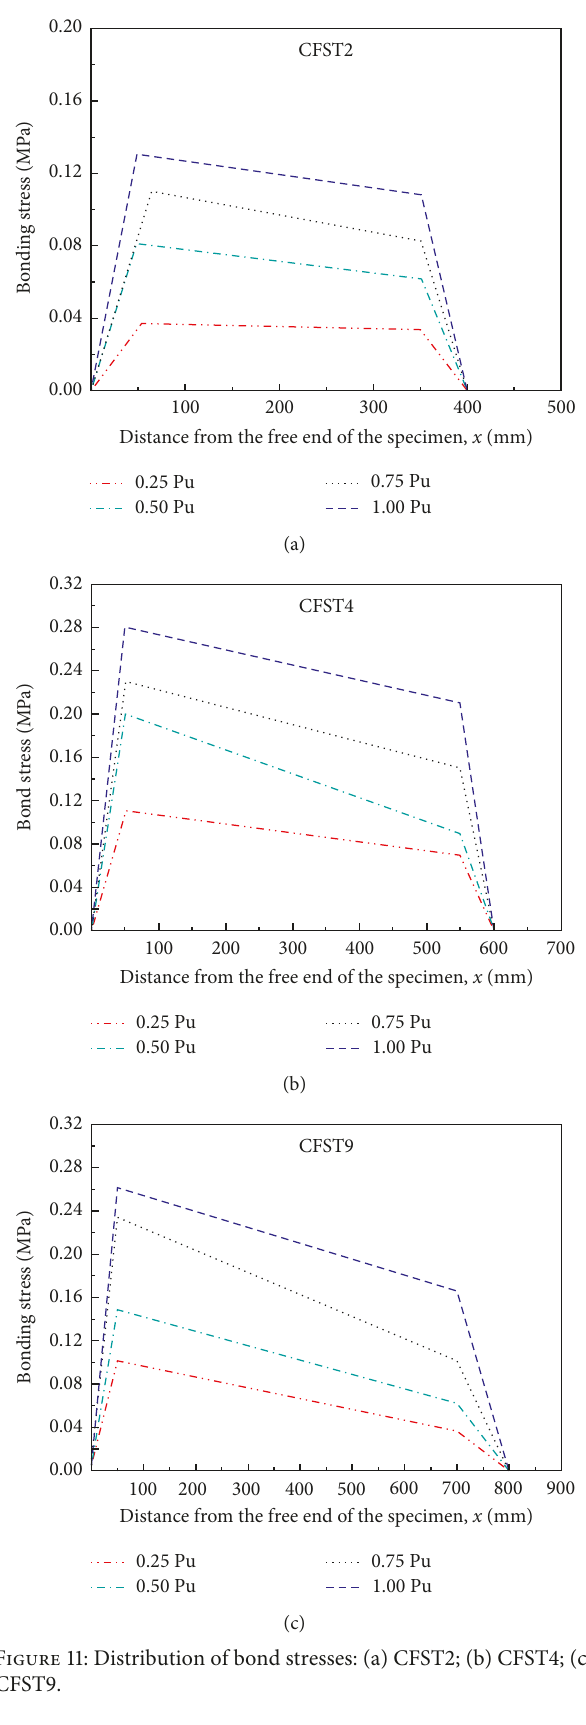
Figure 11: Distribution of bond stresses: (a) CFST2; (b) CFST4; (c)